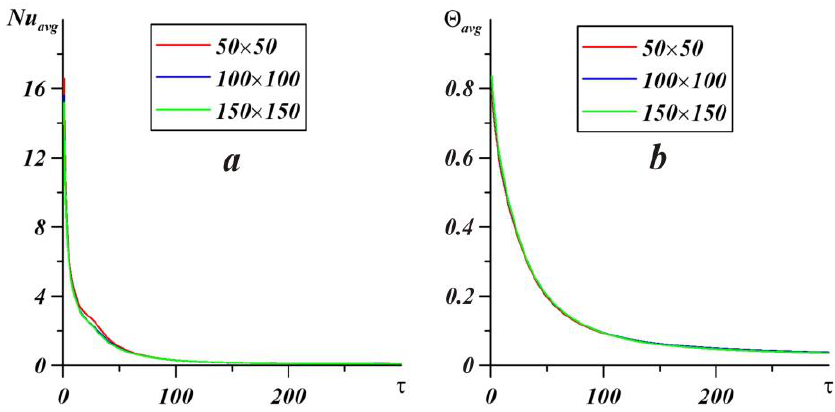
Figure 4. The time dependences of the average Nusselt number ( a ) and average temperature ( b ) at n = 0.6, Ra = 10 5 , k = 1, Pr = 10 2 .